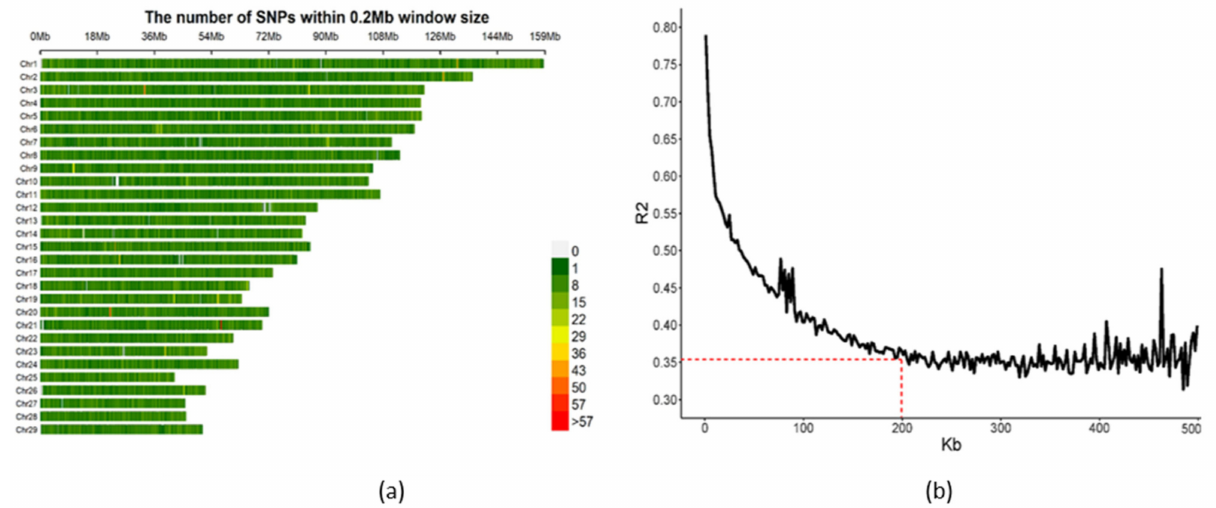
Figure 3. Genotyping chip information used in this study. ( a ) SNPs’ density distribution on 29 autosomes of the bovine genome. The SNP density was calculated per 0.2 Mbp window. ( b ) LD decay plot according to the average distance between SNPs. The R 2 was lower than 0.35 when the average distance between SNPs was around 200